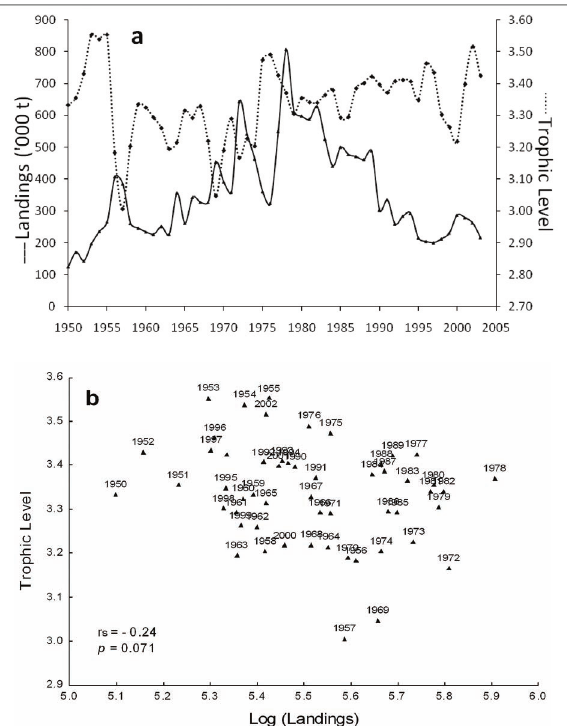
Fig. 1 . – (a) Fishery landings and TLm (mean trophic level) in the Angolan marine ecosystem,1950 to 2003; (b) relationship between TLm and log landings. Data source: FAO (2000,